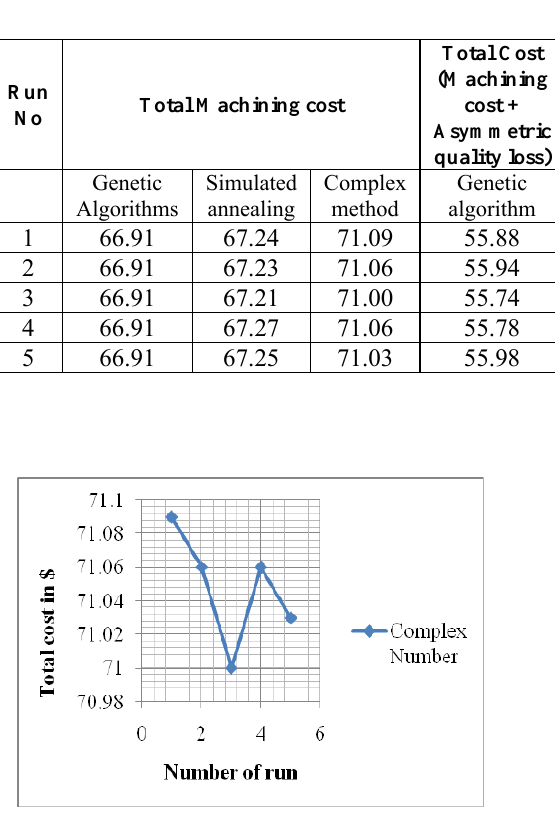
Figure 7 Comparison of total cost with number of trial run for Complex numbers